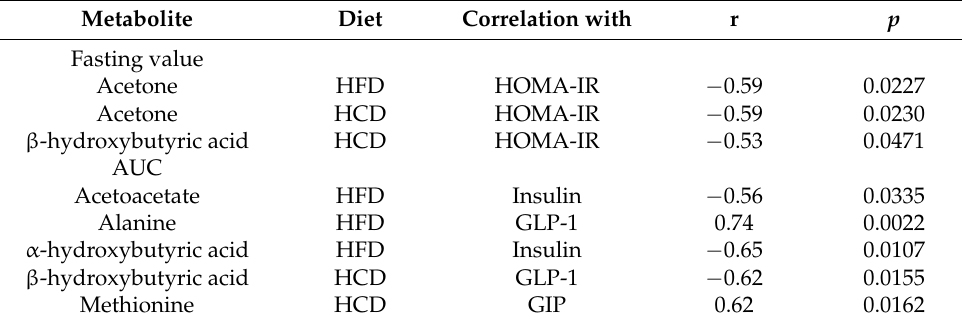
Table 3) and with GLP-1 during the HCD (r-value − 0.62, p = 0.016; Table 3), respectively. Table 3. Correlations between metabolites and HOMA-IR, insulin and